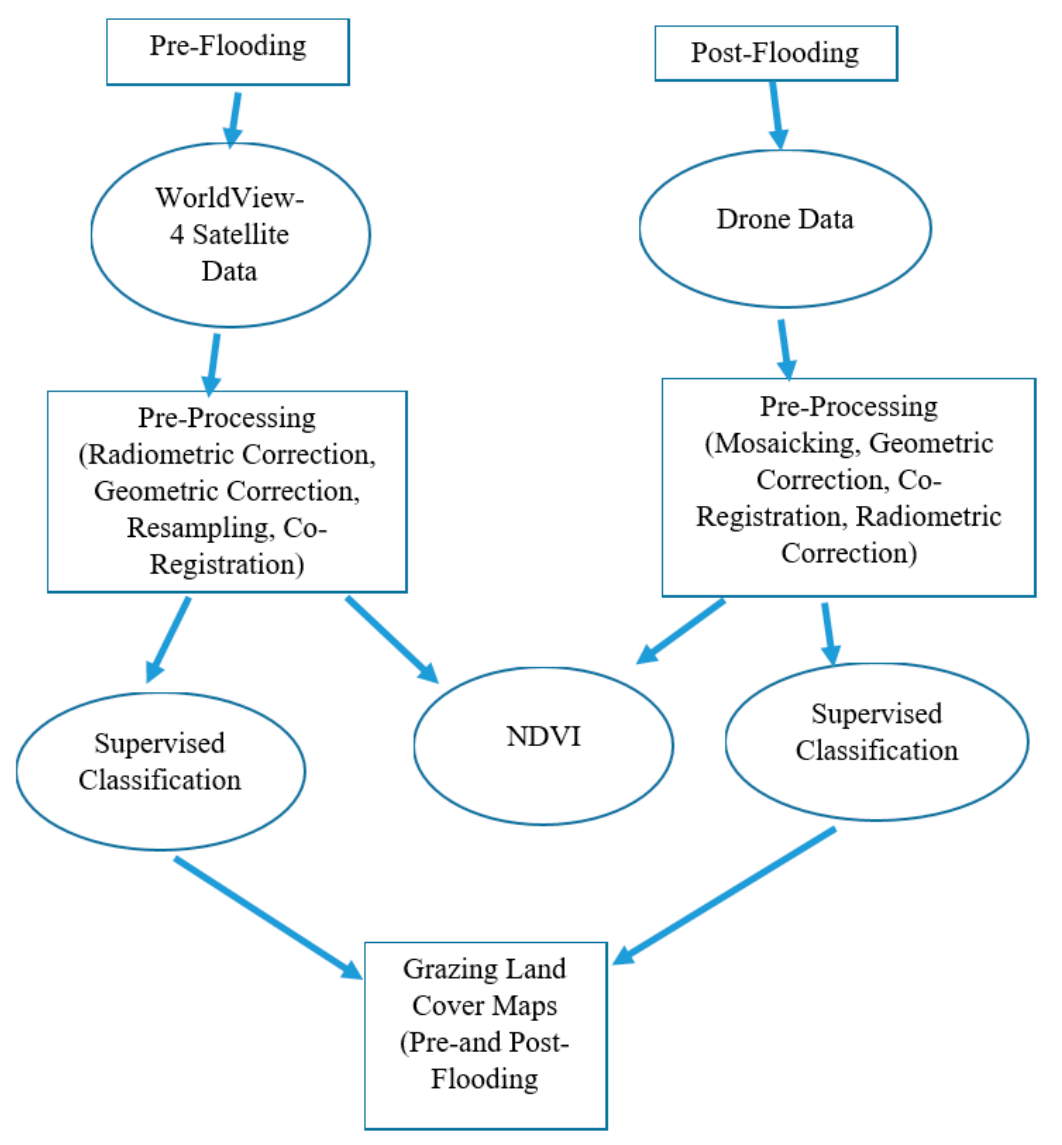
Figure 3. A schematic representation of the methodology.